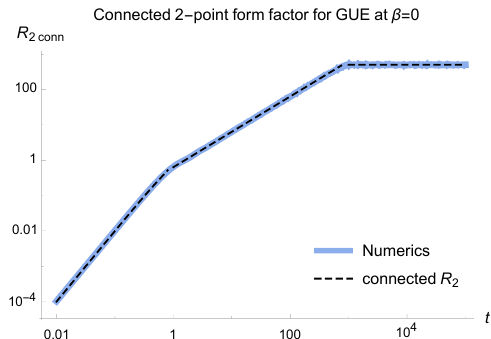
Figure 10 . Numerics for the connected 2-point spectral form factor for GUE at in(cid:12)nite temperature plotted for L = 500 with 10000 random samples. The dashed line is the expression eq. (D.4) approximating the three regimes of the connected form